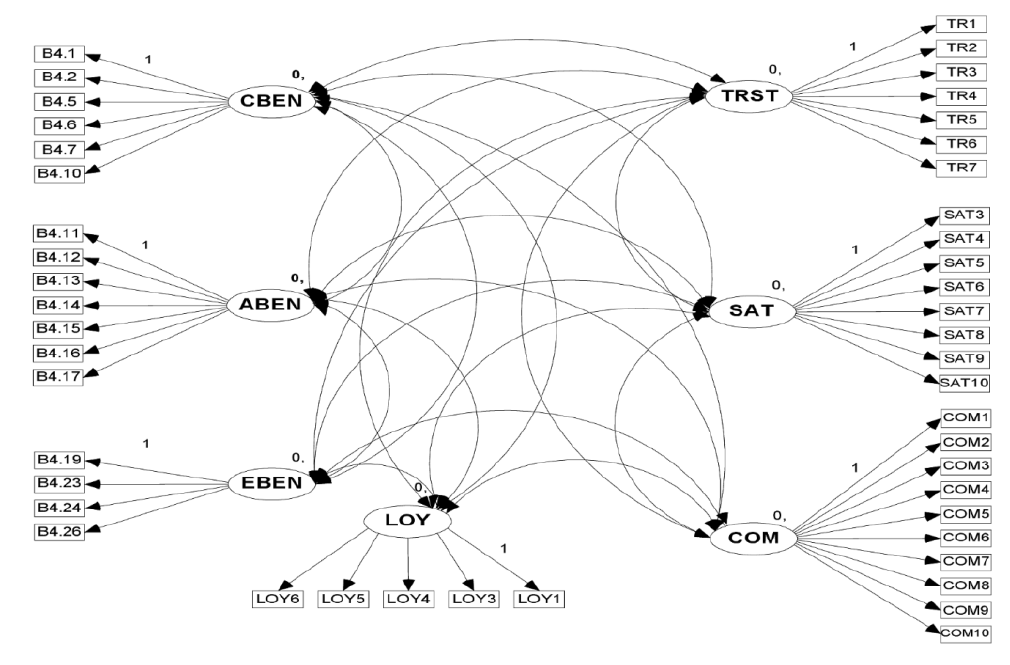
Figure 1: Original Measurement Model (MM); Source : Authors